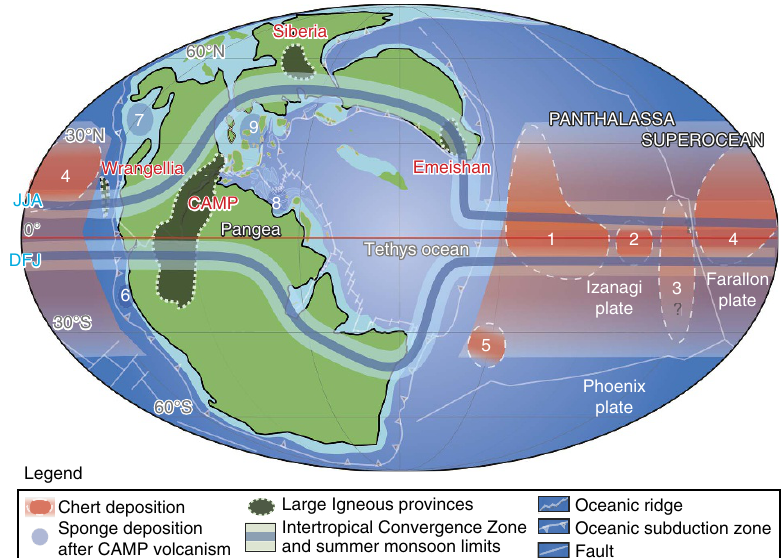
Figure 1 | Palaeogeography in the early Mesozoic. Palaeogeographical map of Pangea and Panthalassa during the Triassic showing the potential distribution of bedded chert deposition (Orange shade) and the localities discussed in the text (dotted and blue areas): 1. Inuyama (central Japan); 2. Tsukumi (SW Japan); 3. Kamuikotan (N Japan); 4. Fraciscan (USA); 5. Waipapa (New Zealand); 6. Central Andes (Peru); 7. Gabbs Valley Range (USA); 8. High Atlas Mountains (Morocco); 9.Northern Calcareous Alps (Austria). The paleogeographic reconstruction is after Vrielynck and Bouysse 66 . The modelled positions of the ITCZ over ocean and the poleward limit of summer monsoon over land at JJA and DJF are from Kutzbach and Gallimore 42 .